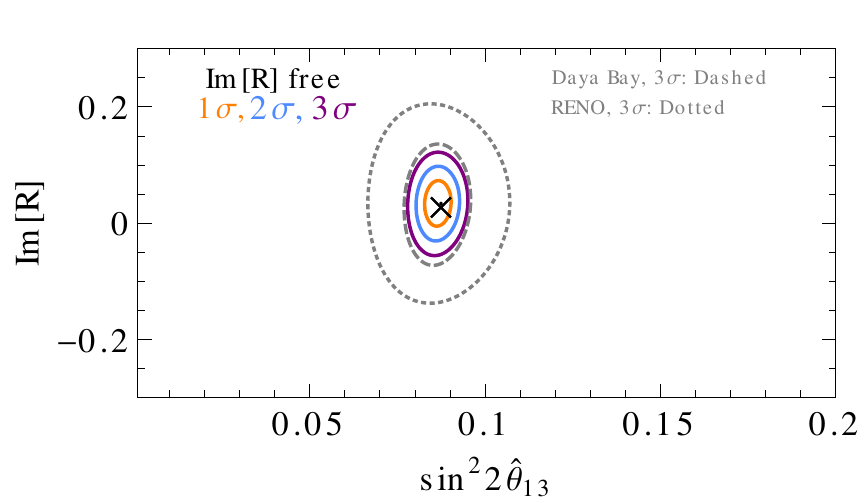
Figure 4 . Allowed regions in the (sin 2 2^ (cid:18) 13 (cid:0) Im [ R ]) plane for the combined data of the Daya Bay and RENO experiments. The 1-, 2-, and 3- (cid:27) regions are shown with orange, blue, and purple, respectively. The Daya Bay and RENO 3 (cid:27) regions are shown with the grey dashed and dotted curves,